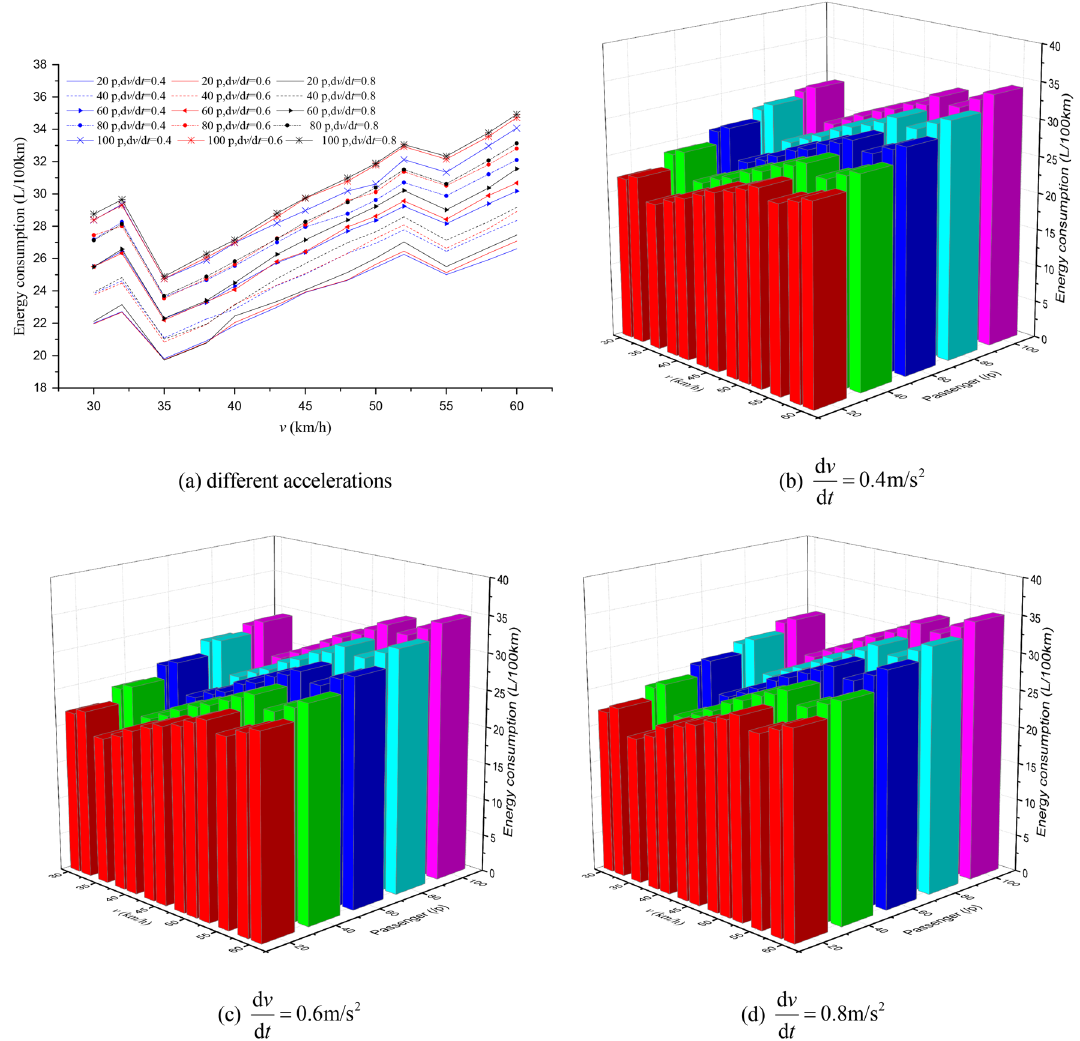
Figure 12. The EC of different passenger load, acceleration and maximum speed for 1500 m station